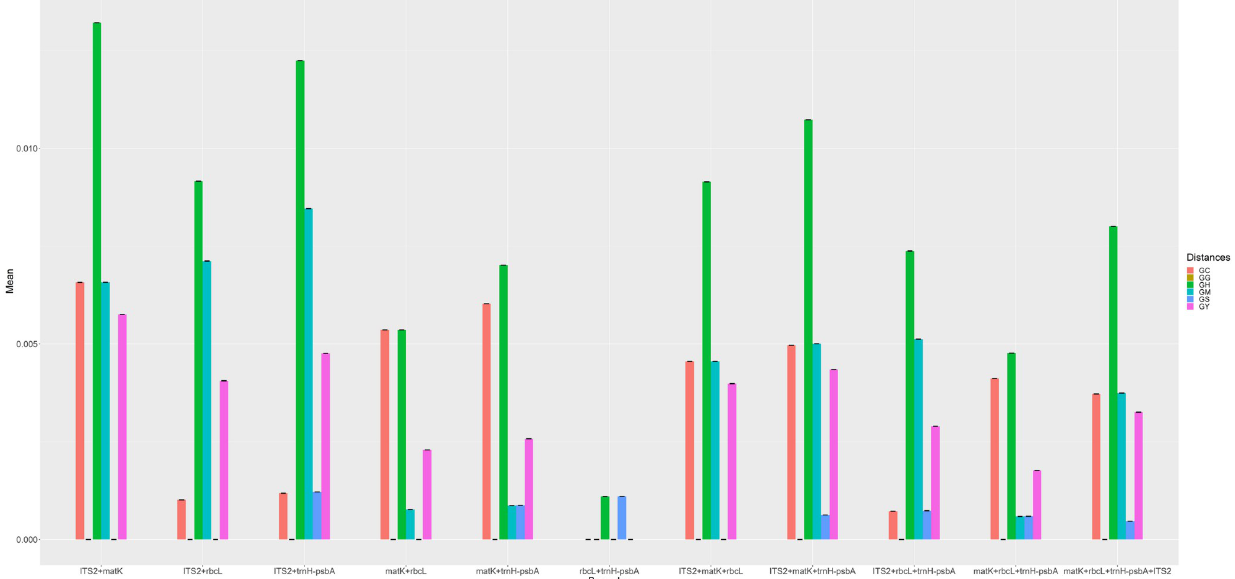
Fig 4. Genetic distances between 58 Qi-Nan germplasms and the Aquilaria species for multilocus combinations. ( GC : interspecific distance between the Qi-Nan germplasm and A . crassna . GG : intraspecific distance among the Qi-Nan germplasms. GH : interspecific distance between the Qi-Nan germplasm and A . hirta . GM : interspecific distance between the Qi-Nan germplasm and A . malaccensis . GS : interspecific distance between the Qi-Nan germplasm and A . sinensis . GY : interspecific distance between the Qi-Nan germplasm and A . yunnanensis ).